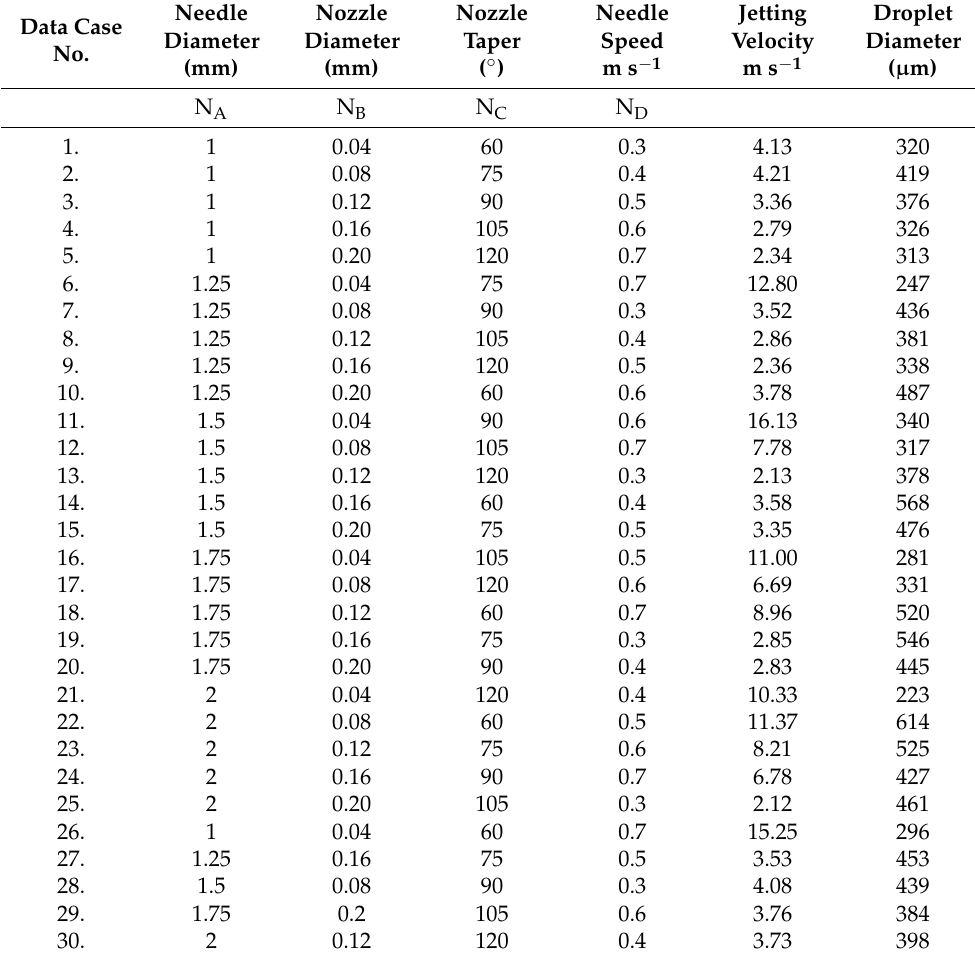
Table 2. Design of parameter combinations based on Taguchi orthogonal method. Data